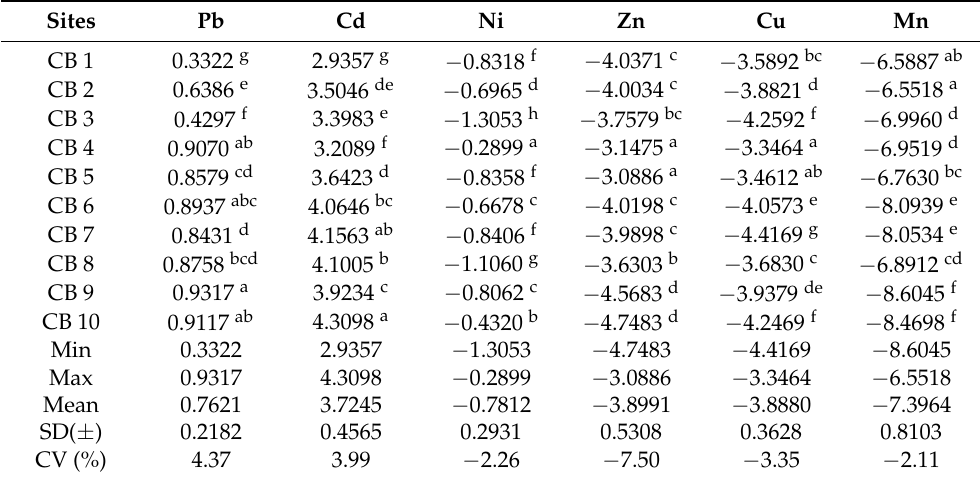
Table 5. Geo-accumulation index ( I geo ) of heavy metals for all sediment samples of Chalan beel area. Sites Pb Cd